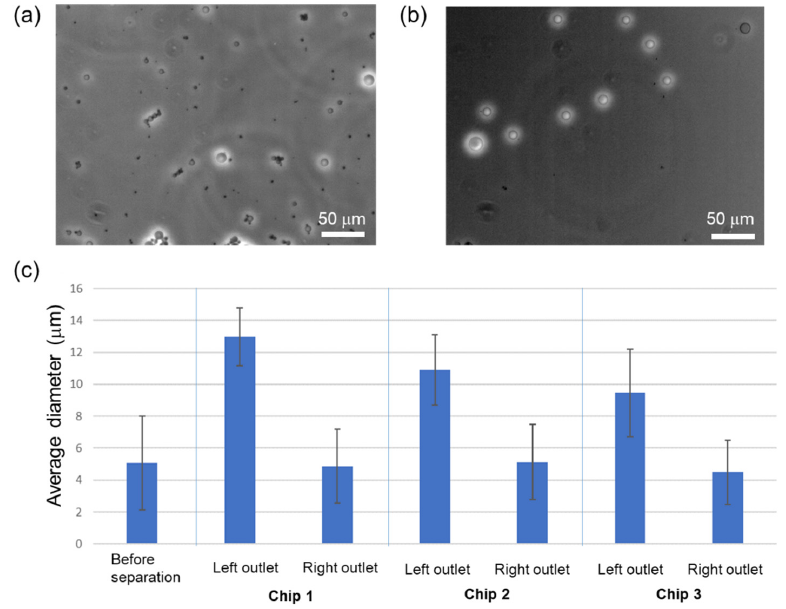
outlet were greater than those in the right outlet, suggesting that spherical particles with larger diameters were sorted based on the DLD mechanism.